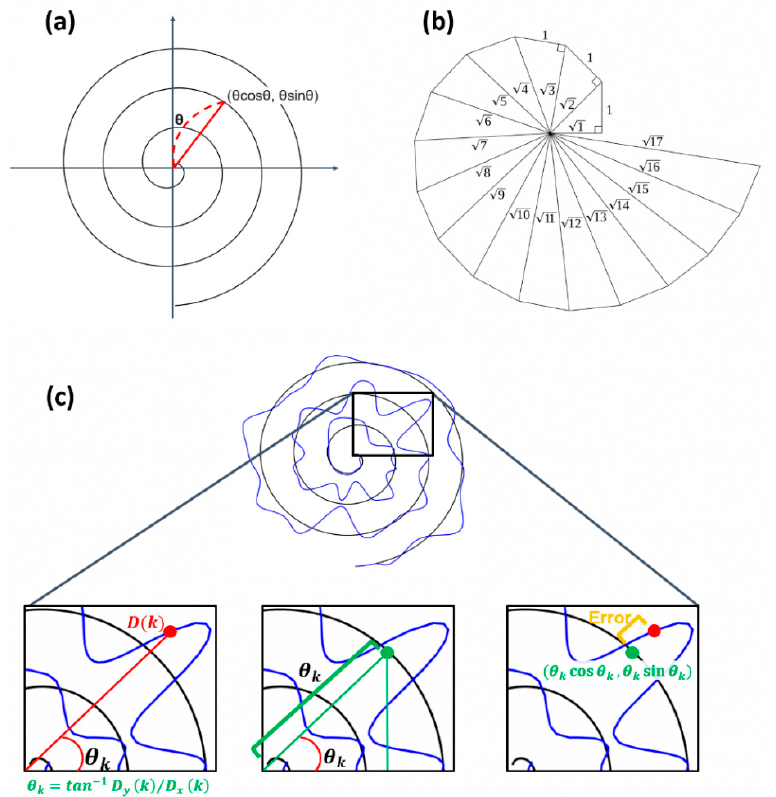
Figure 2. Illustration of the procedure calculating error distance using EA. ( a ) Example of Archime- dean spiral. ( b ) Angle within the spiral. ( c ) Description of how the proposed algorithm works.